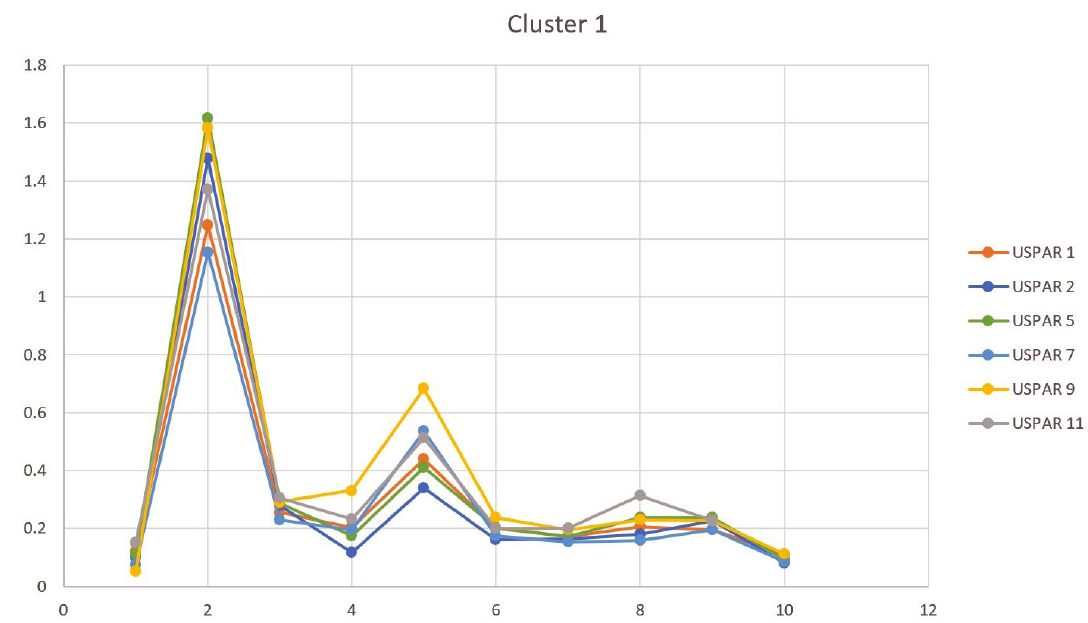
Figure 12: The signature characteristic of cluster 1. The same pattern is noted in Roman Levantine I and Early Medieval Jarrow glass fragments as presented in Freestone